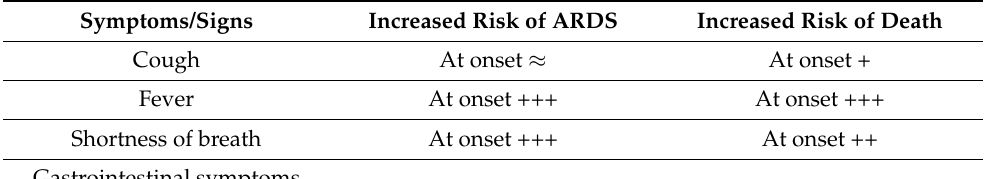
Table 1. Significance of symptoms and signs of COronaVIrus Disease 19 (COVID-19) in chronic kidney disease (CKD) patients